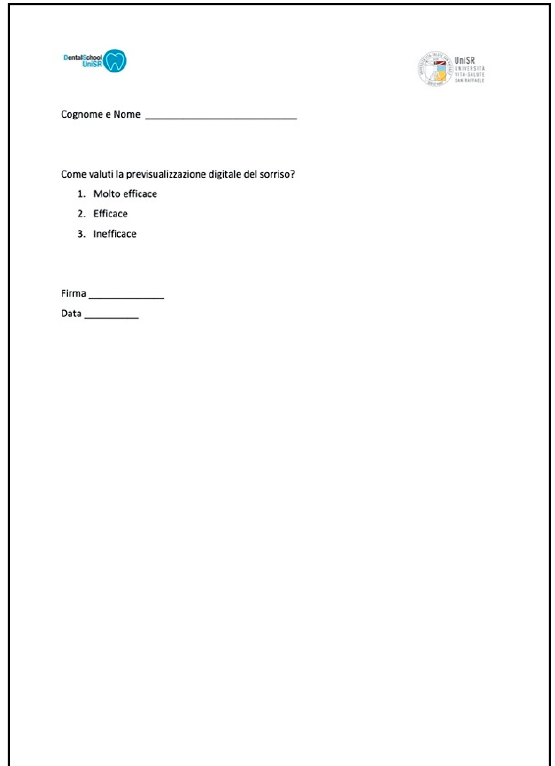
Figure A3. Questionnaire 3.